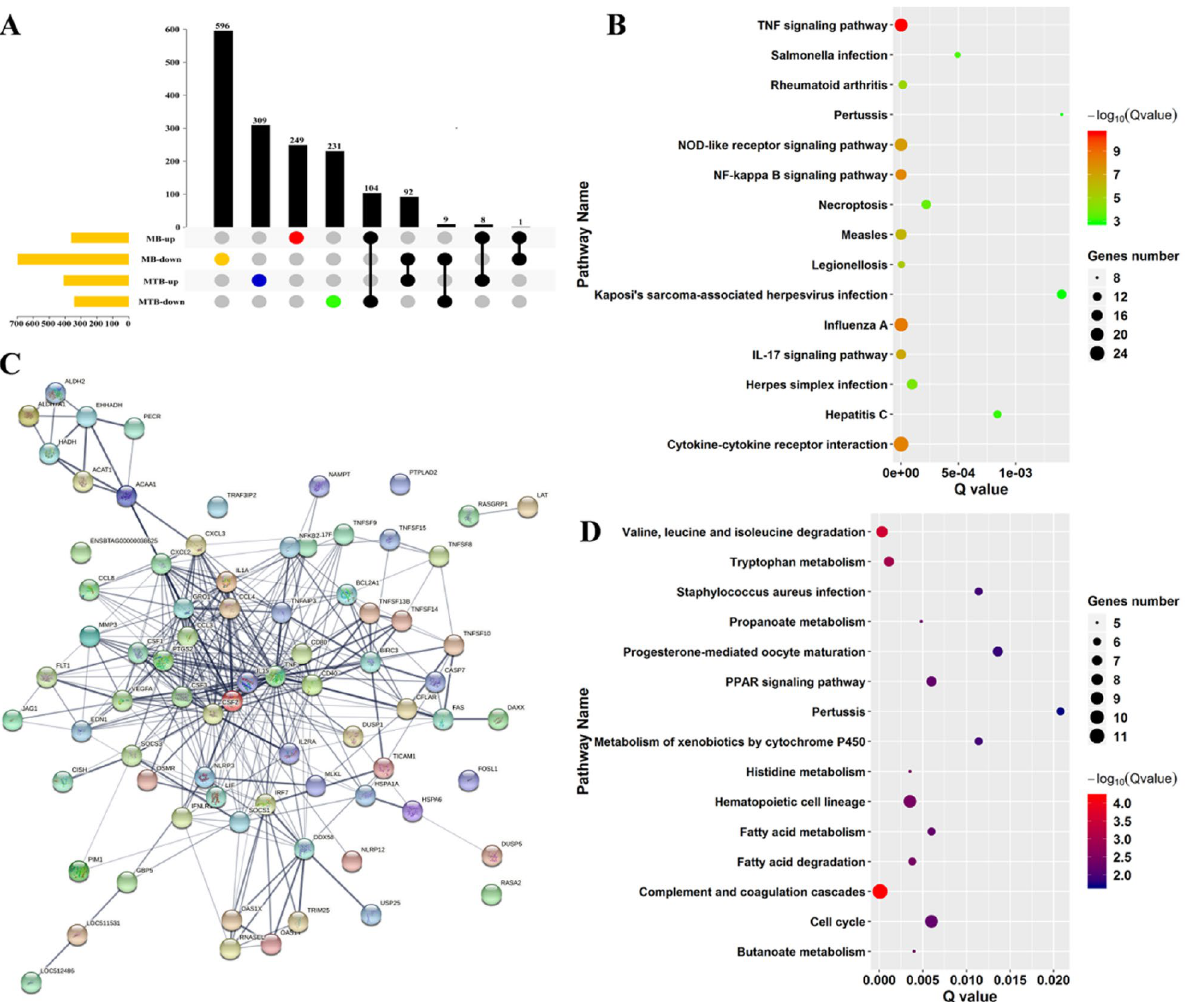
Figure 6. Co-expression network and pathway enrichment analysis of key genes involved in the BAM lipid metabolism. ( A ) Up-set diagrams representing the overlap of identified differentially expressed genes in both MTB- and MB-infected groups. ( B ) Enrichment results of differentially expressed genes associated with MTB- infected BAM. The color shows the significance of pathways. The number of genes involved in the pathway is represented by the dot size. ( C ) Protein–protein interaction network between genes involved in lipid metabolism and signaling pathways. Each circle represented an individual protein. ( D ) Pathway enrichment result of genes associated with MB infection. Transcriptomic datasets were collected from published articles, as shown in Table